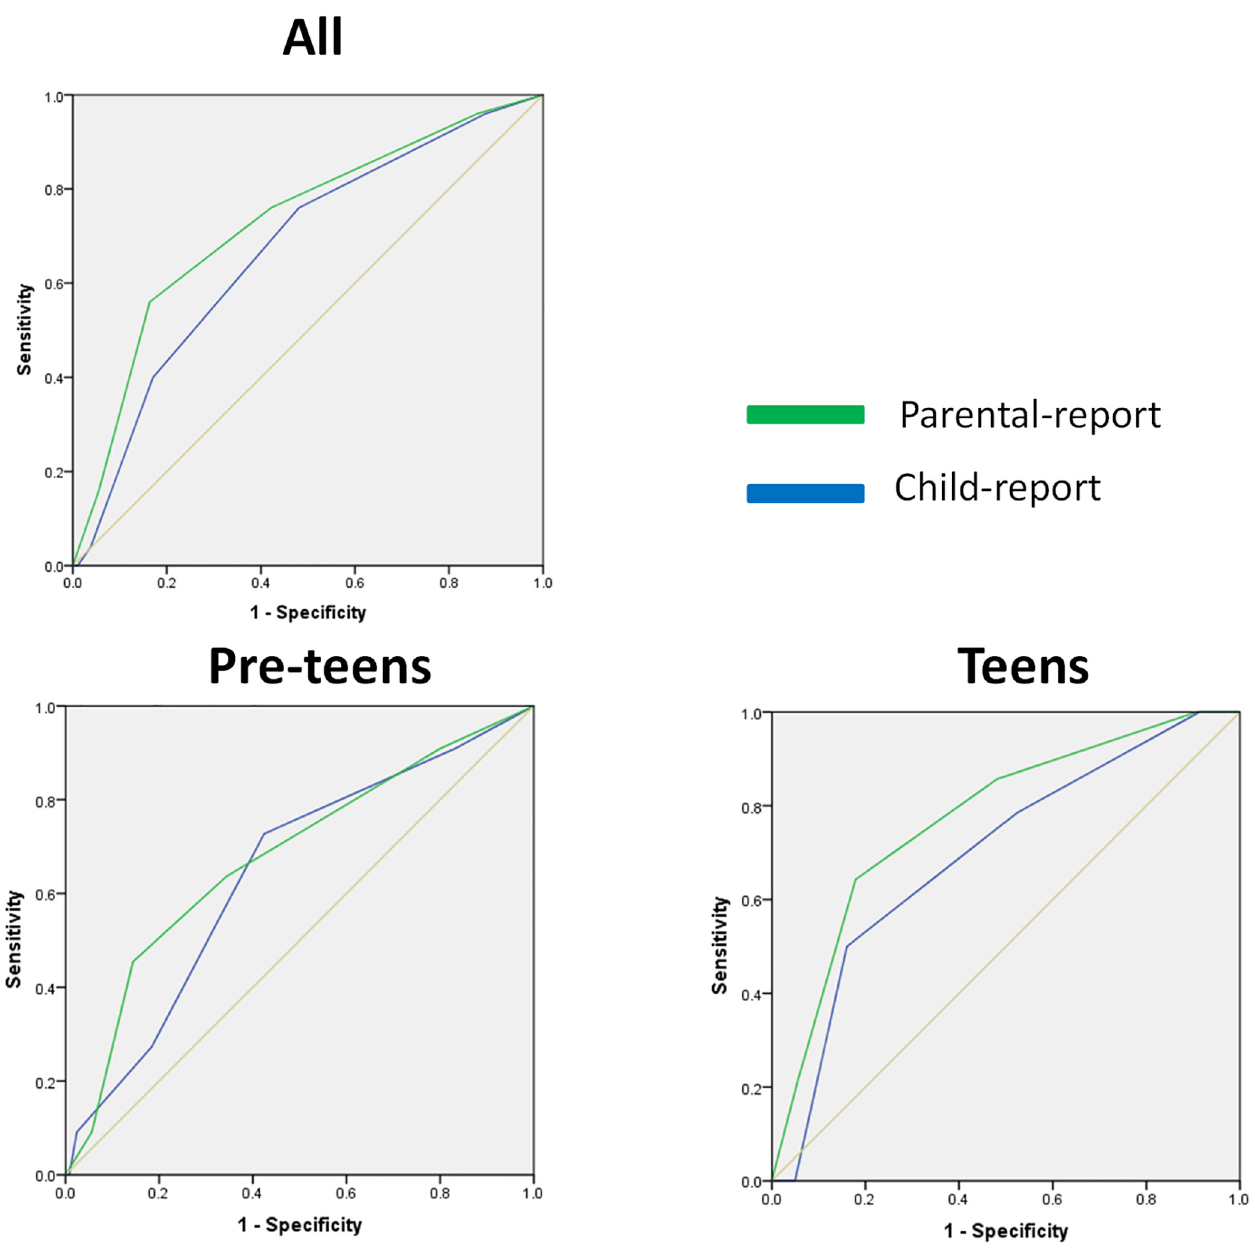
Fig 1. Receiver operating characteristics of teen STOP-Bang. Receiver operating characteristics (ROC) for modified STOP-Bang scores that were child- reported (blue lines) or parent-reported (green line) in discriminating presence of obstructive sleep apnea (defined as an apnea-hypopnea index (cid:1) 1.5 / hour). The ROC area under the curve for all (top left), pre-teens (bottom left) and teens (bottom right) are shown.